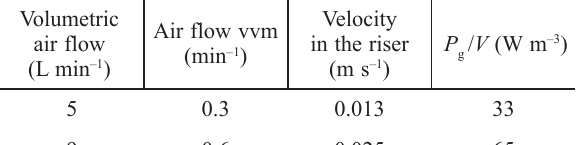
Table 2 – Air flow, linear velocities, and specific power input in the airlift Volumetric air